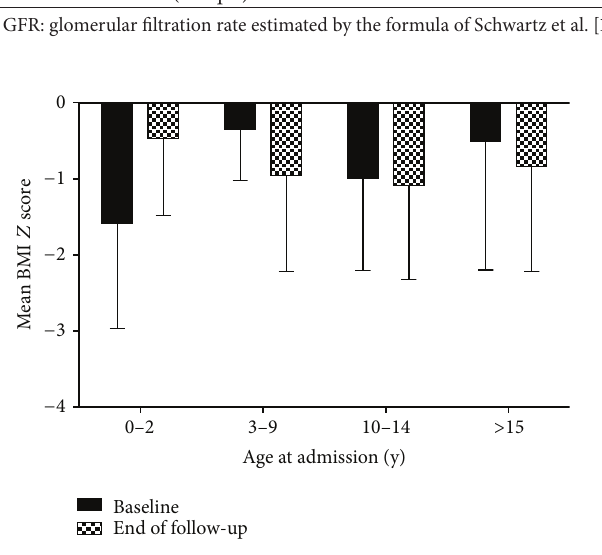
these differences did not reach statistical significance ( 𝑃 = 0.333